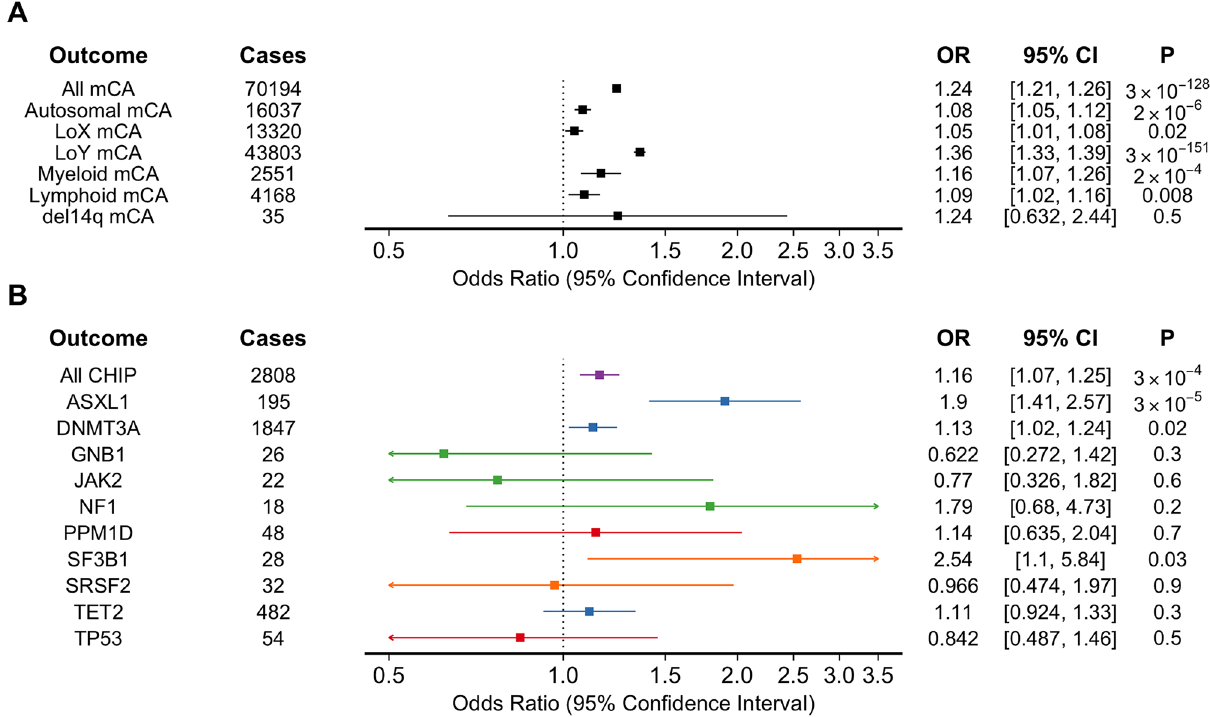
Figure 1. Observational associations between Ever smoking and somatic mutations among UK Biobank participants. Associations between ever smoking and ( A ) manifestations of mCA and ( B ) manifestations of CHIP among UK Biobank participants. Colors represent specific types of CHIP mutations (Purple = any CHIP, Blue = epigenetic, Red = DNA damage repair, Orange = splicing, Green = other). mCA = mosaic chromosomal alteration; LoX = loss-of-X chromosome; LoY = loss-of-Y chromosome; del =